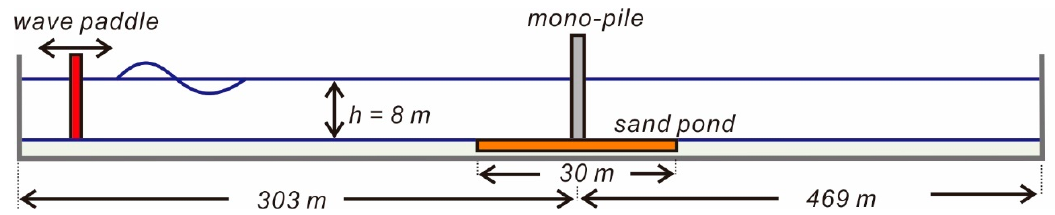
Figure 13. Quattro-pod mono-pile.